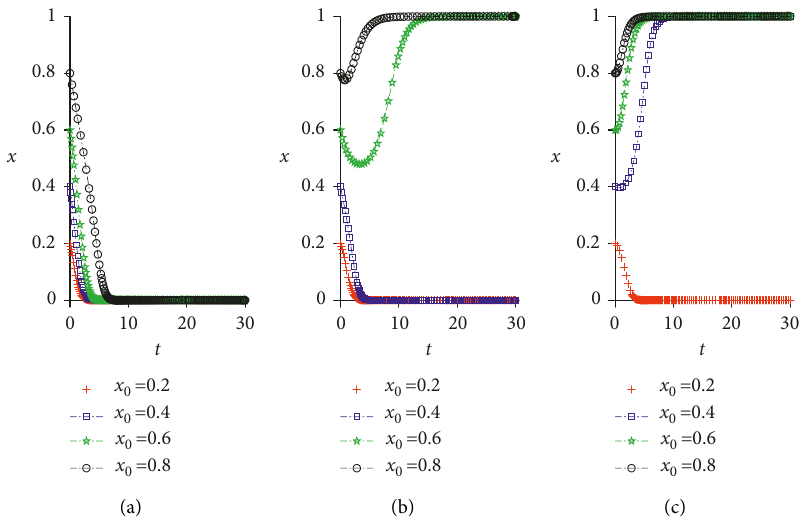
Figure 10: Impact of π on system evolution. Comparing (a), (b), and (c), as π operation strategy) increases, the probability of the system evolving to the ideal state increases. (a) ′